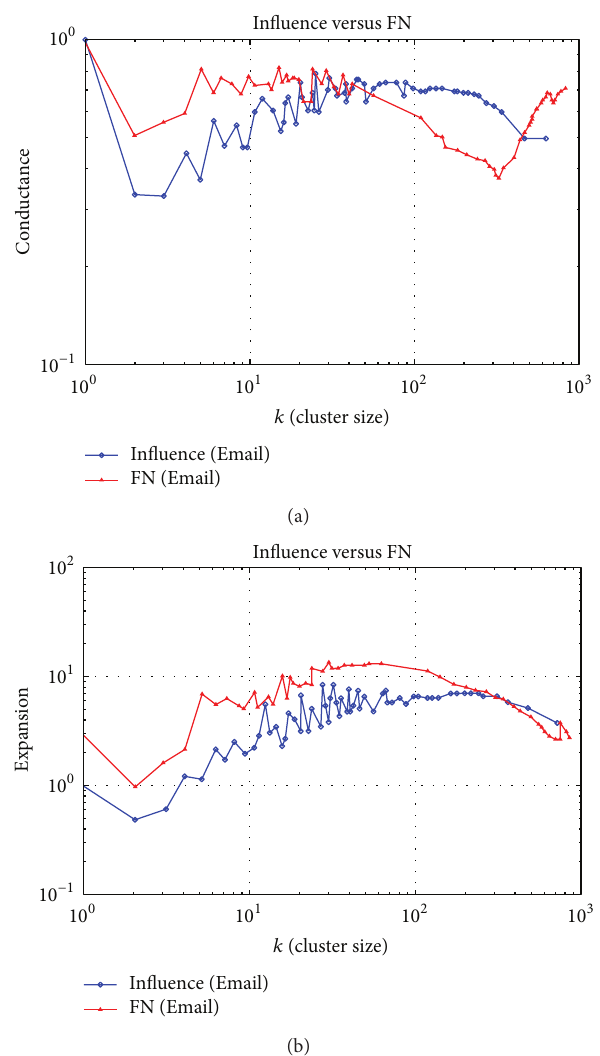
Figure 3: Evaluating values of the clustering effect of the Email dataset.